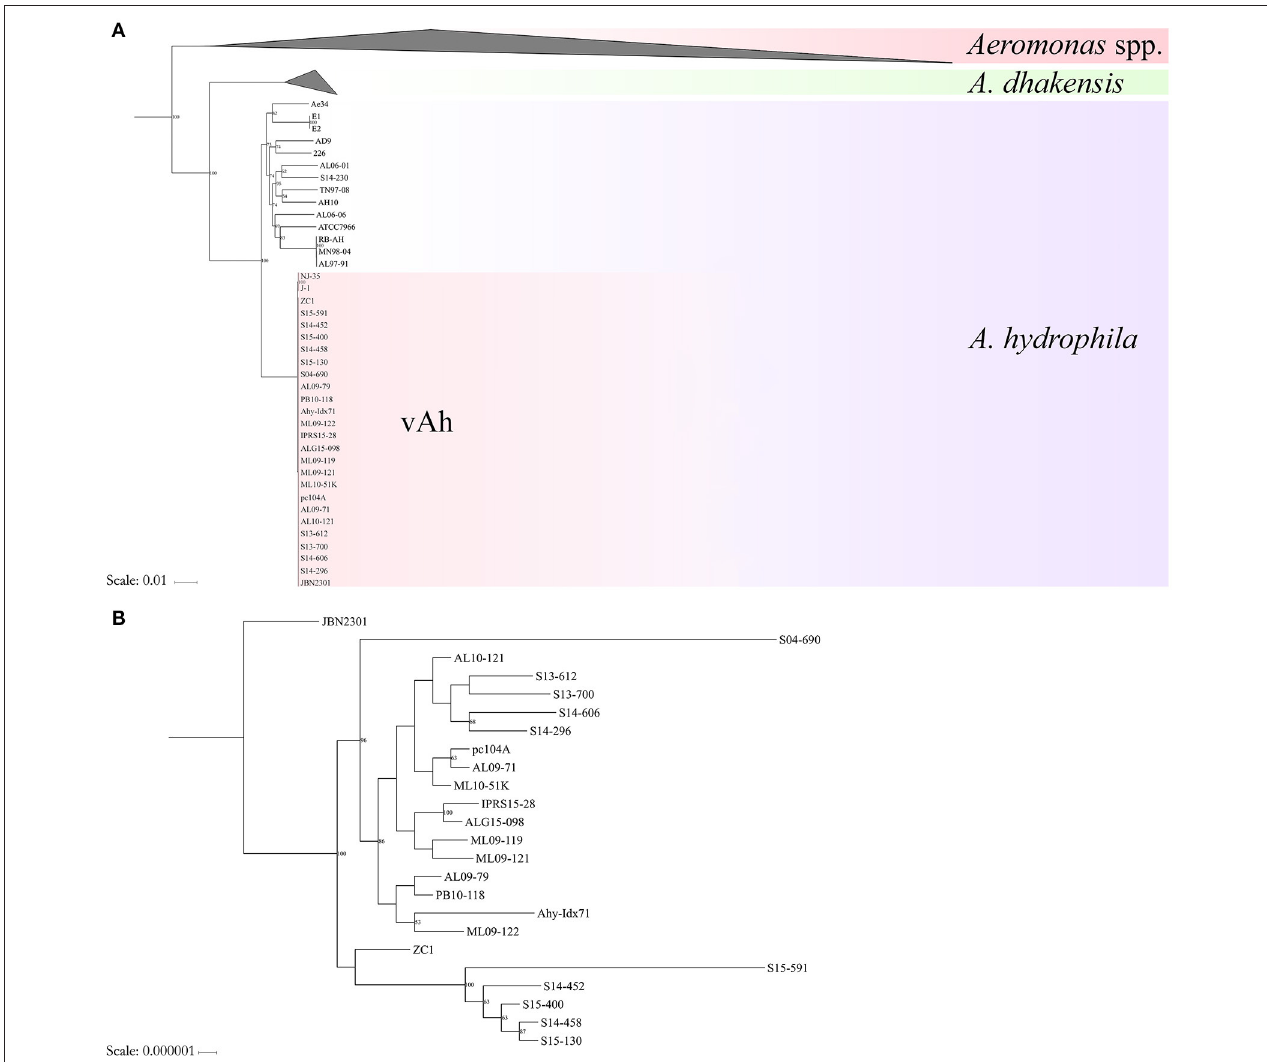
FIGURE 1 | Maximum likelihood (ML) phylogeny of (Panel A) Aeromonas spp. and (Panel B) vAh isolates based on the core genome of 3.78 Mb conserved among these bacterial